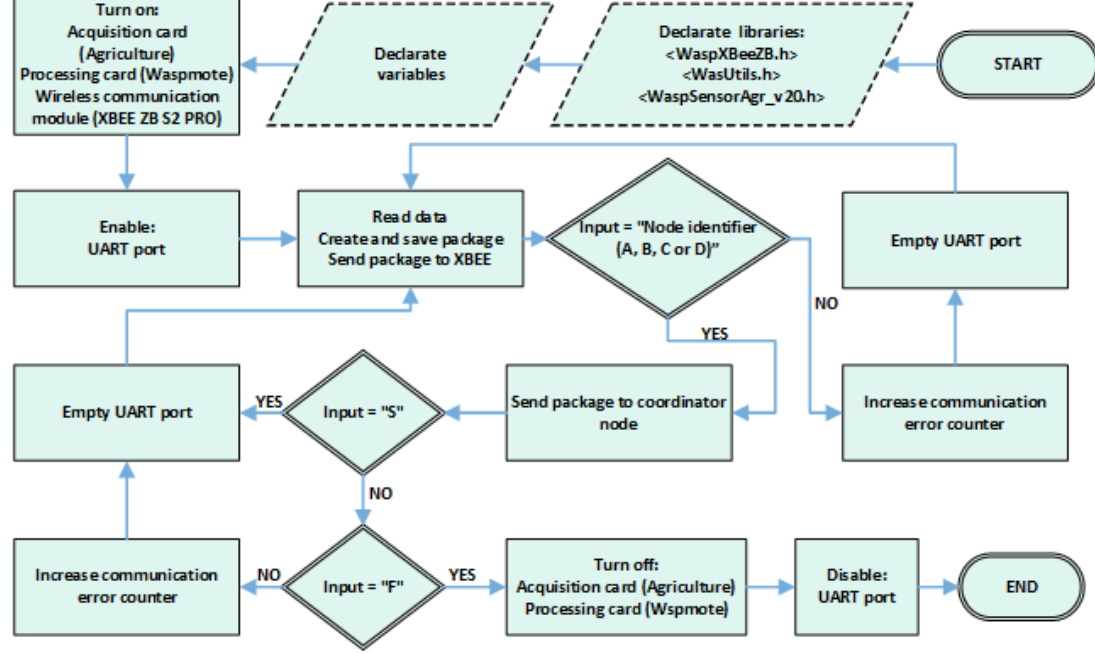
Figure A1. Flowchart of logic programming sensor nodes of the ZigBee